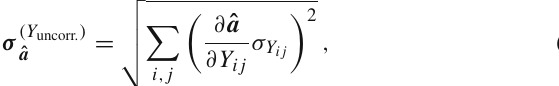
data are displayed for comparison at the best estimator ˆ α of the Linear TemplateFit.Forcomparison,thelinearizedmodelfromEq.(15)isalso displayed, which is otherwise not used when log-normally distributed estimators are